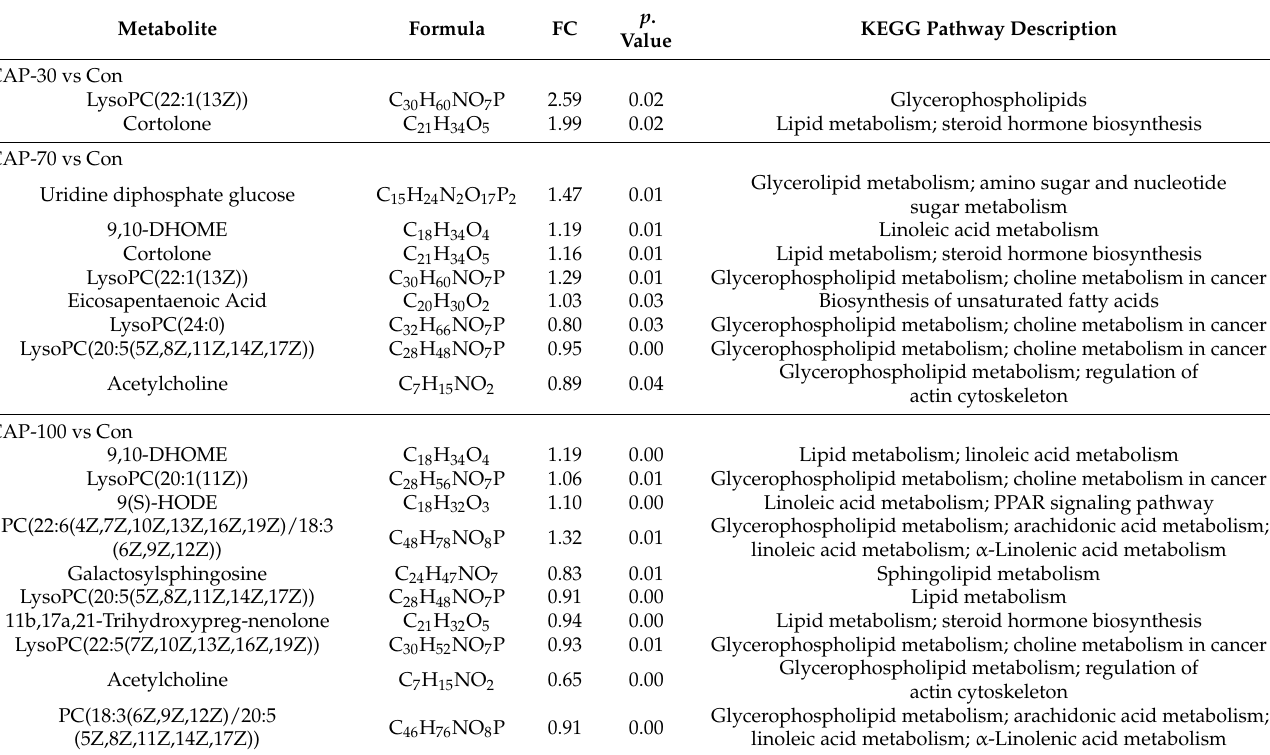
Table 10. List of discriminating KEGG metabolites in CAP-30, CAP-70, CAP-100 and control